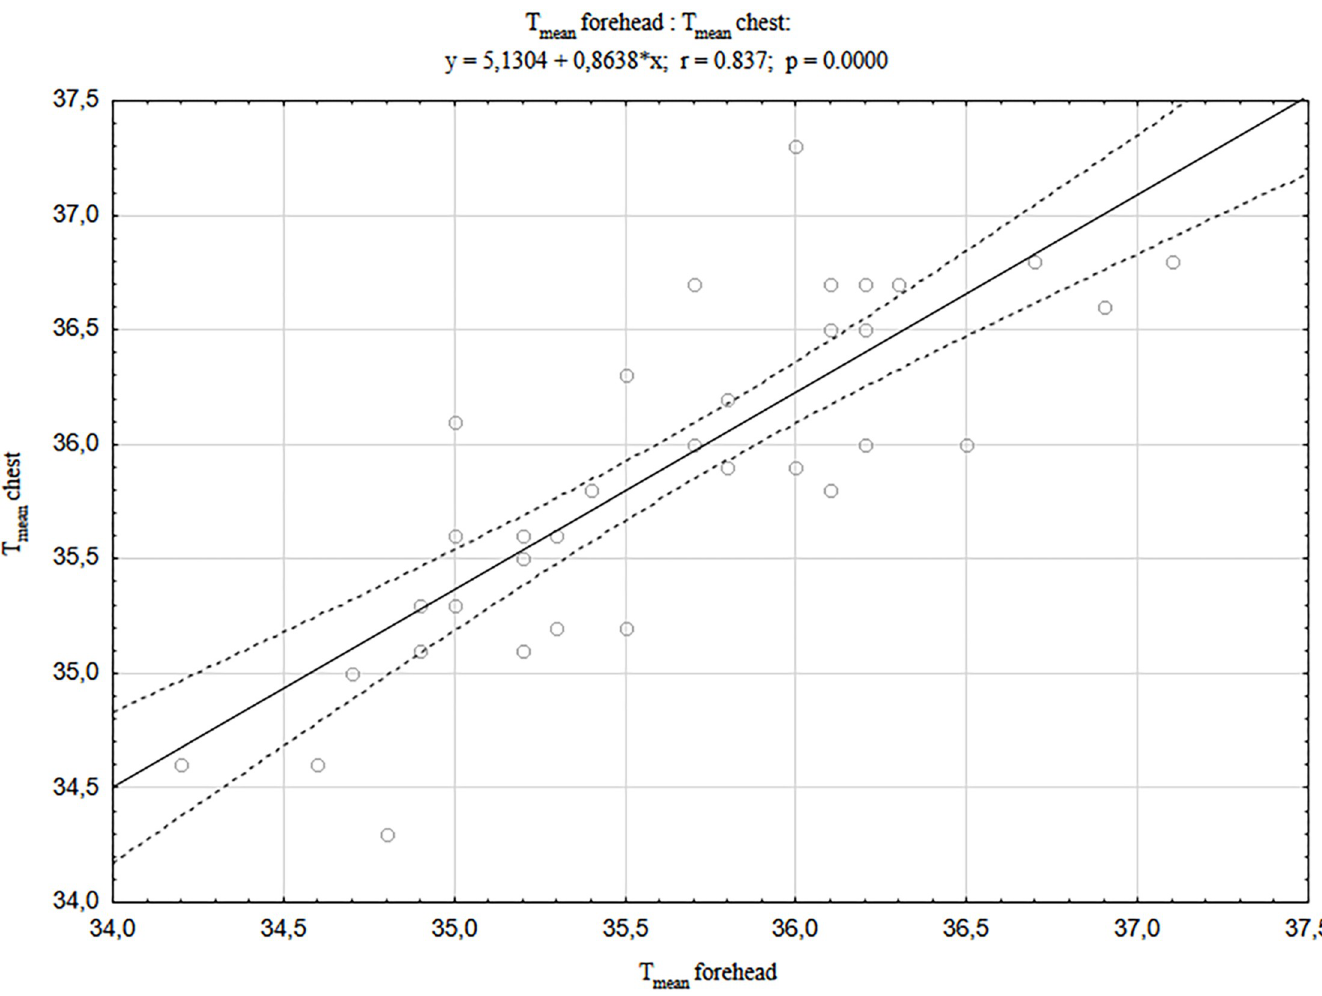
Fig 1. A correlation between T mean forehead and T mean chest in newborns born by